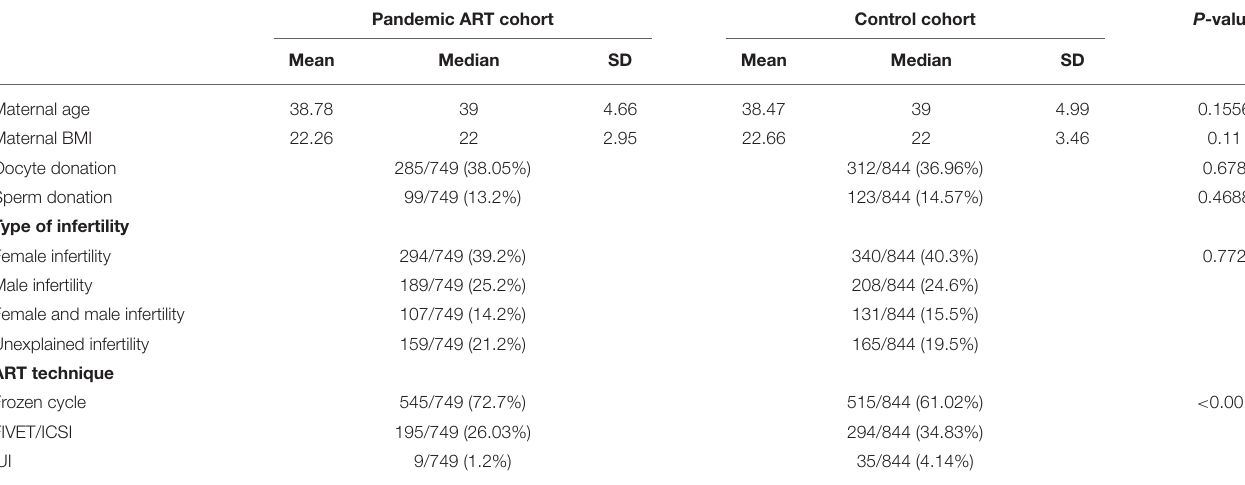
TABLE 1 | Pandemic assisted reproductive technology (ART) cohort and control cohort